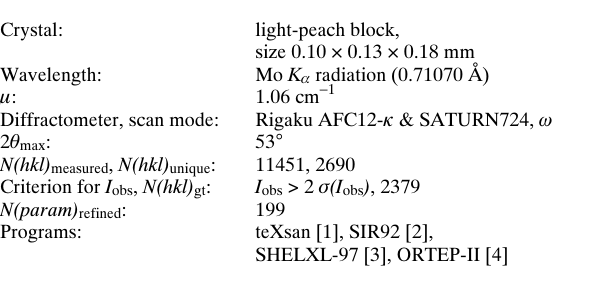
Table 1. Data collection and handling.